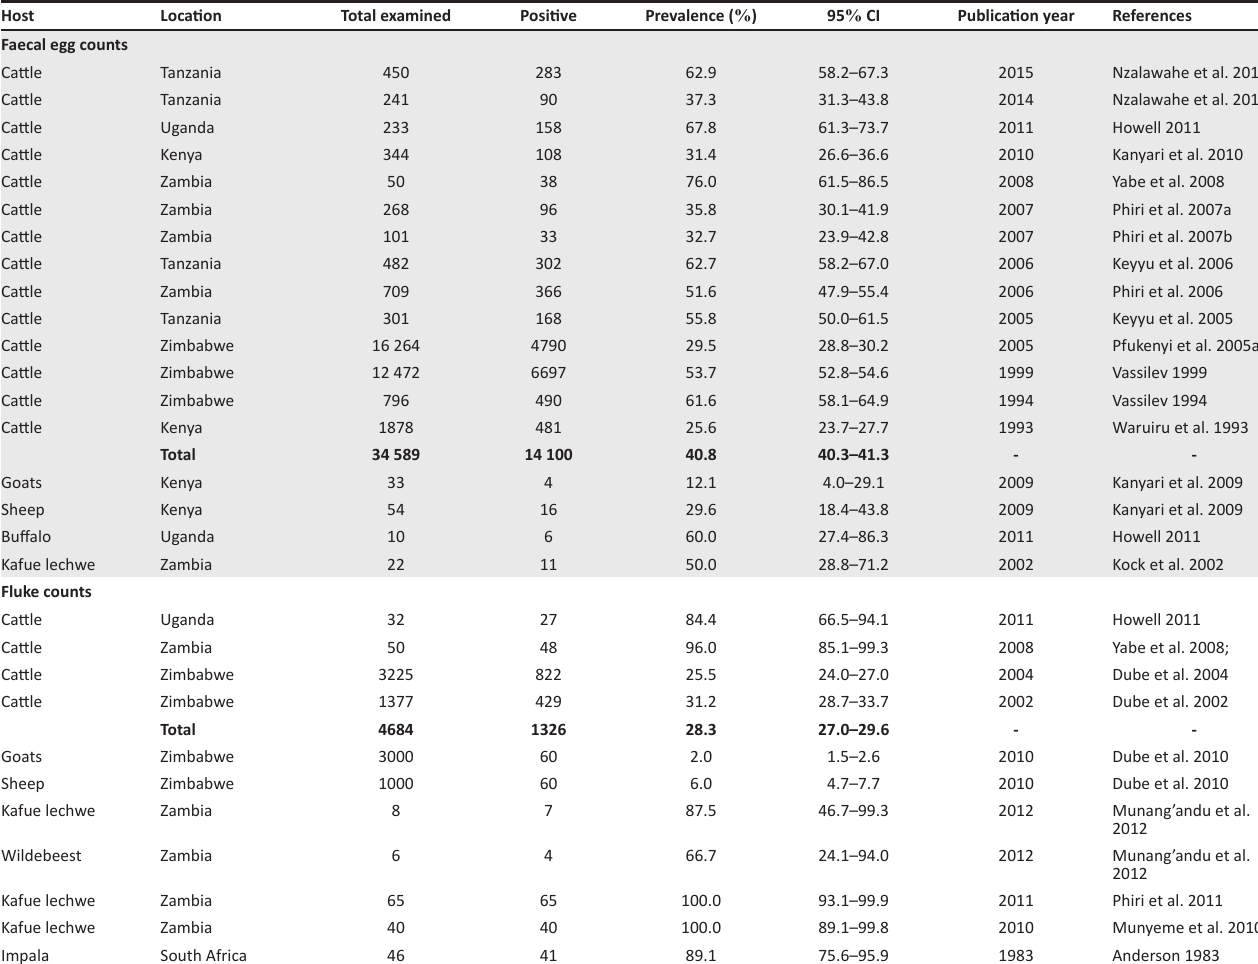
TABLE 2: Prevalence of amphistomes in ruminants in east and southern African countries based on faecal egg and fluke counts. Host